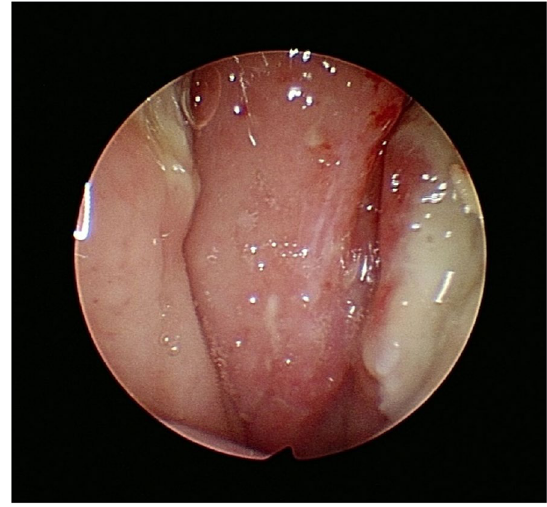
Fig. 1 Endoscopic appearance of the nasopharynx revealing slough on bilateral torus tubarius, predominantly on the left side